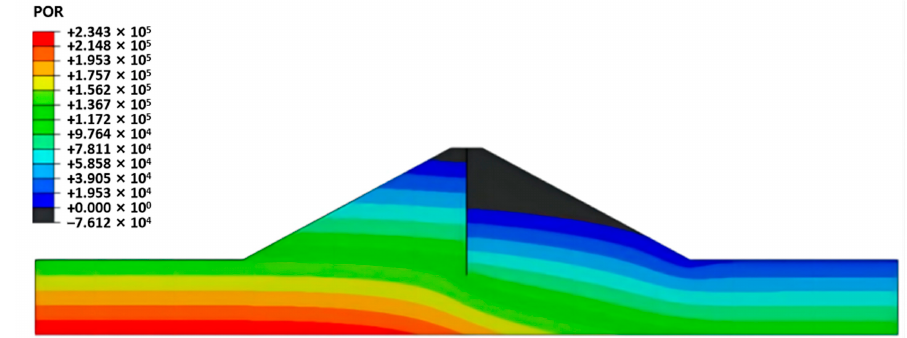
Figure 6. The water pressure in the pores.